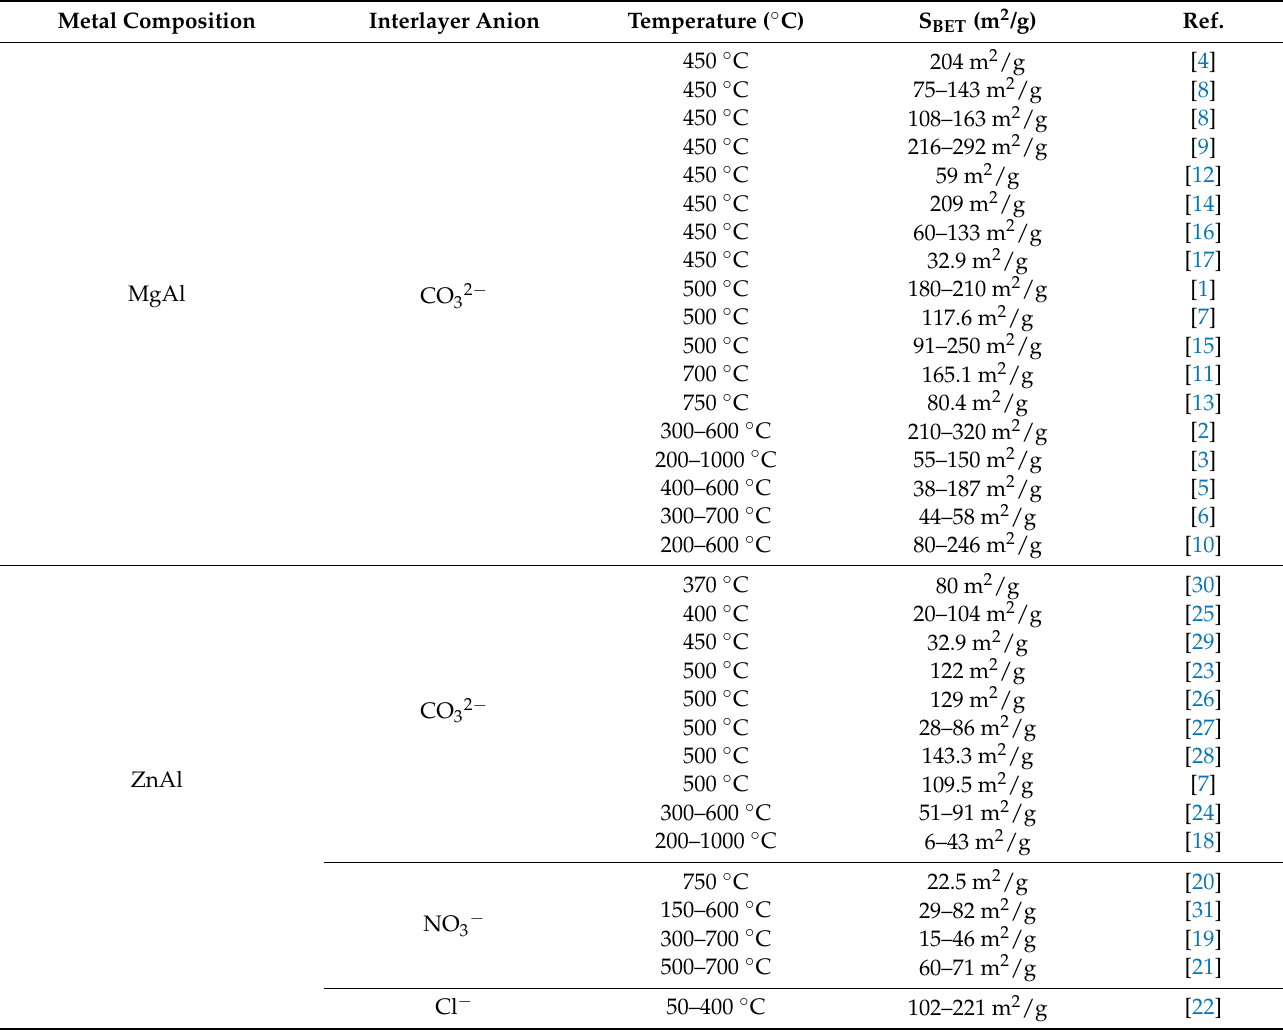
Table 1. Specific surface area values of MMOs depending on metal composition, interlayer anion, and calcination temperature. Metal